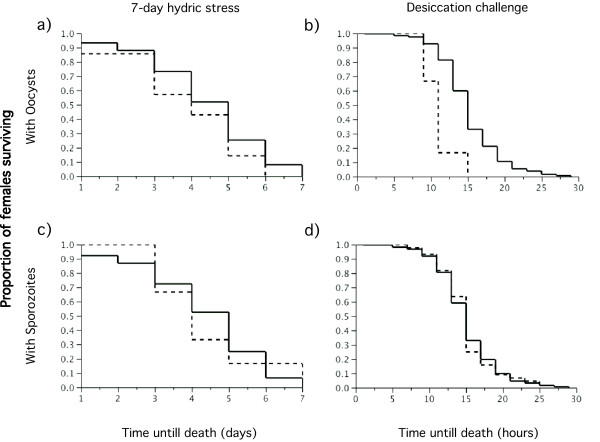
Survival of An. gambiae s.s. females infected with oocysts (a,b dashed line) and sporozoites (c,d dashed line) and those found without parasites (a-d solid lines). Survival curves were calculated for the 7-day period with experimental manipulation of water availability (a,c) and for the shorter desiccation challenge (b,d).